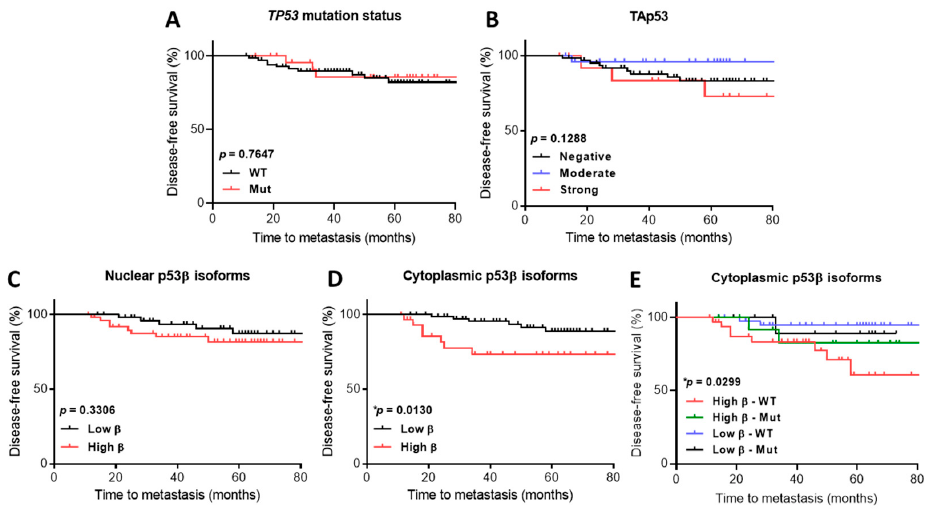
Figure 5. p53 isoform expression is associated with worse disease-free survival. Kaplan–Meier survival curve representing disease-free survival of ( A ) 98 patients who had TP53 mutation status and metastasis data available [20]; cases were distributed based on TP53 mutation status into wild-type (black, n = 72) or mutated (red, n = 26). ( B ) Cases ( n = 103) segregated based on TAp53 expression into negative (black, n = 63), moderate (blue, n = 26) or strong (red, n = 14). ( C ) Cases ( n = 103) segregated based on nuclear p53 β expression into low (black, n = 53) or high (red, n = 50). ( D ) Cases ( n = 103) segregated based on cytoplasmic p53 β expression into low (black, n = 72) or high (red, n = 31). ( E ) Cases ( n = 98) segregated based on cytoplasmic p53 β expression and TP53 mutation status into low p53 β with mutated TP53 (black, n = 12), low p53 β with wild-type TP53 (blue, n = 39), high p53 β with mutated TP53 (green, n = 14) or high p53 β with wild-type TP53 (red, n = 33). Log-rank (Mantel–Cox) test was used to determine statistical significance. Results were considered significant at p < 0.05 (*).